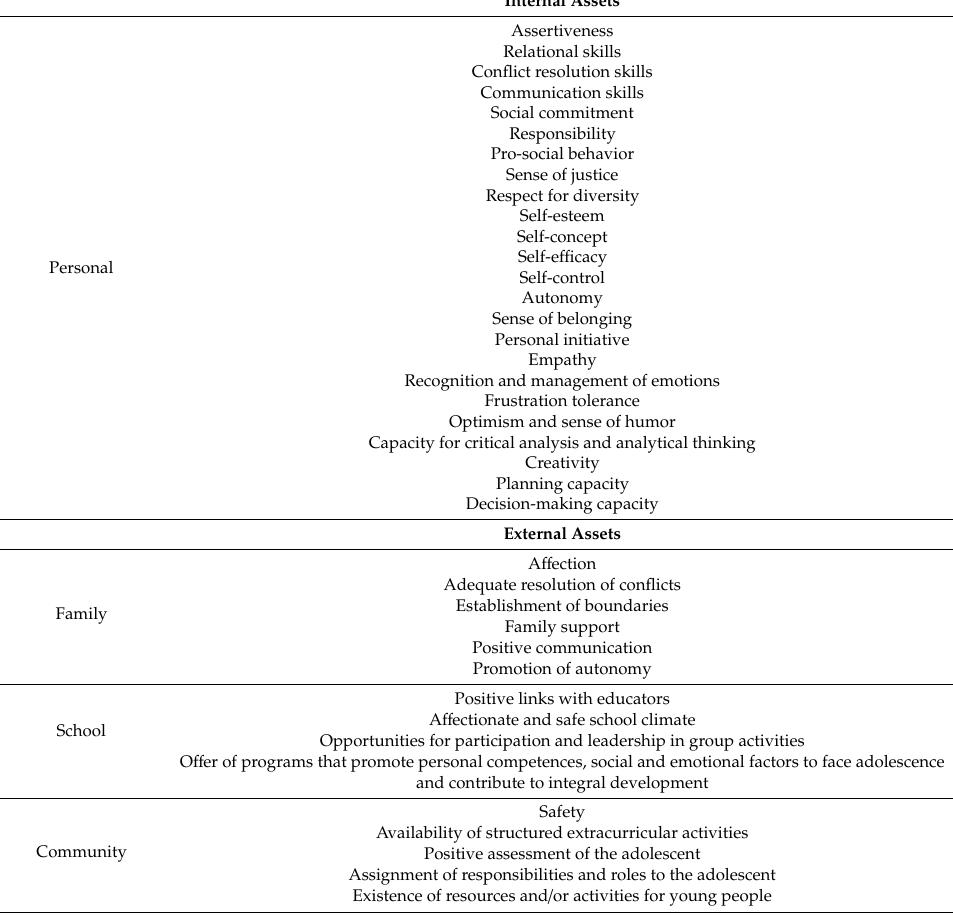
Table 2. Categories for identification of assets that adolescents describe to resolve violent situations in their first sentimental